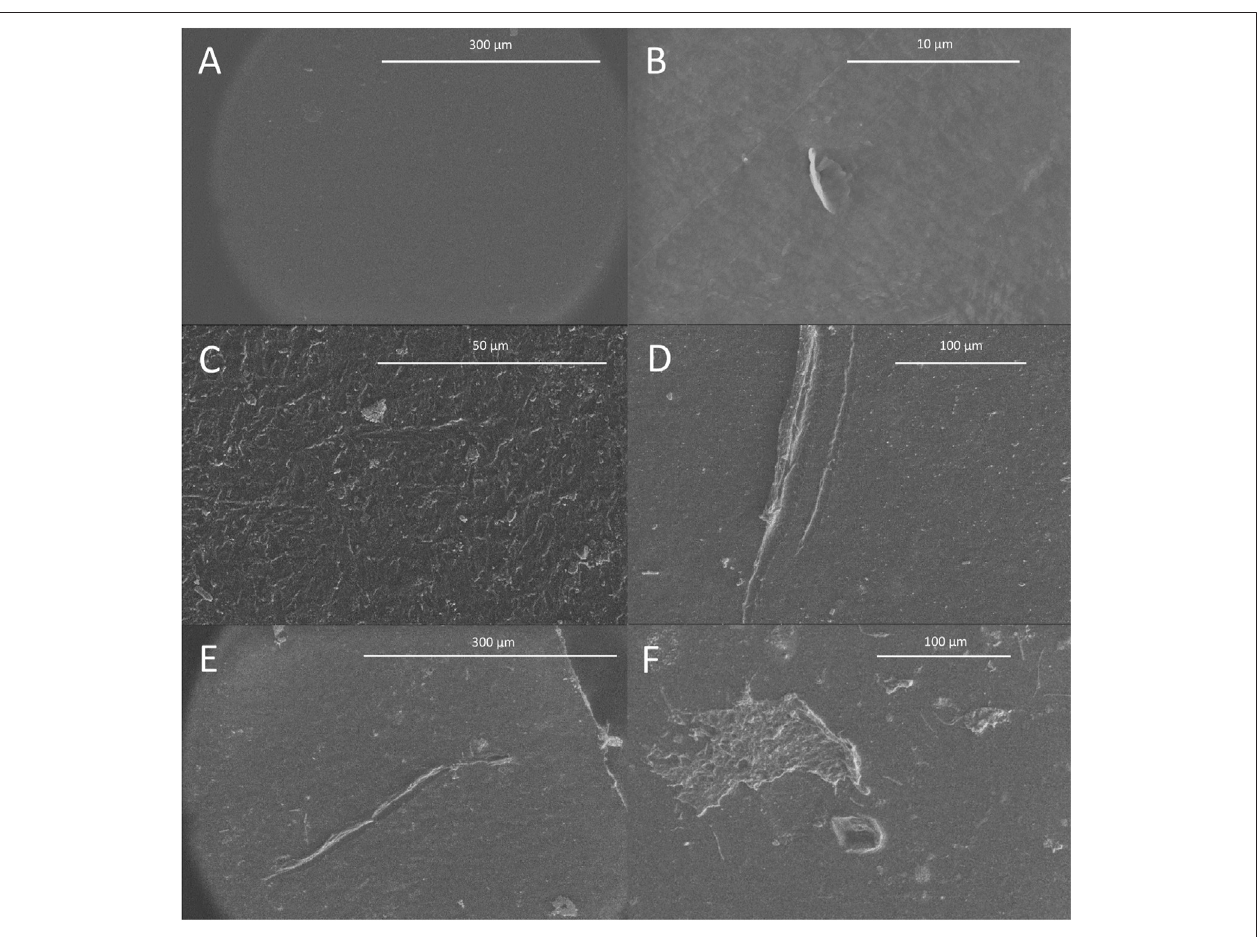
FIGURE 6 | E-SEM micrographs of reference (A,B) and exposed (C – F) PHA fi lms.